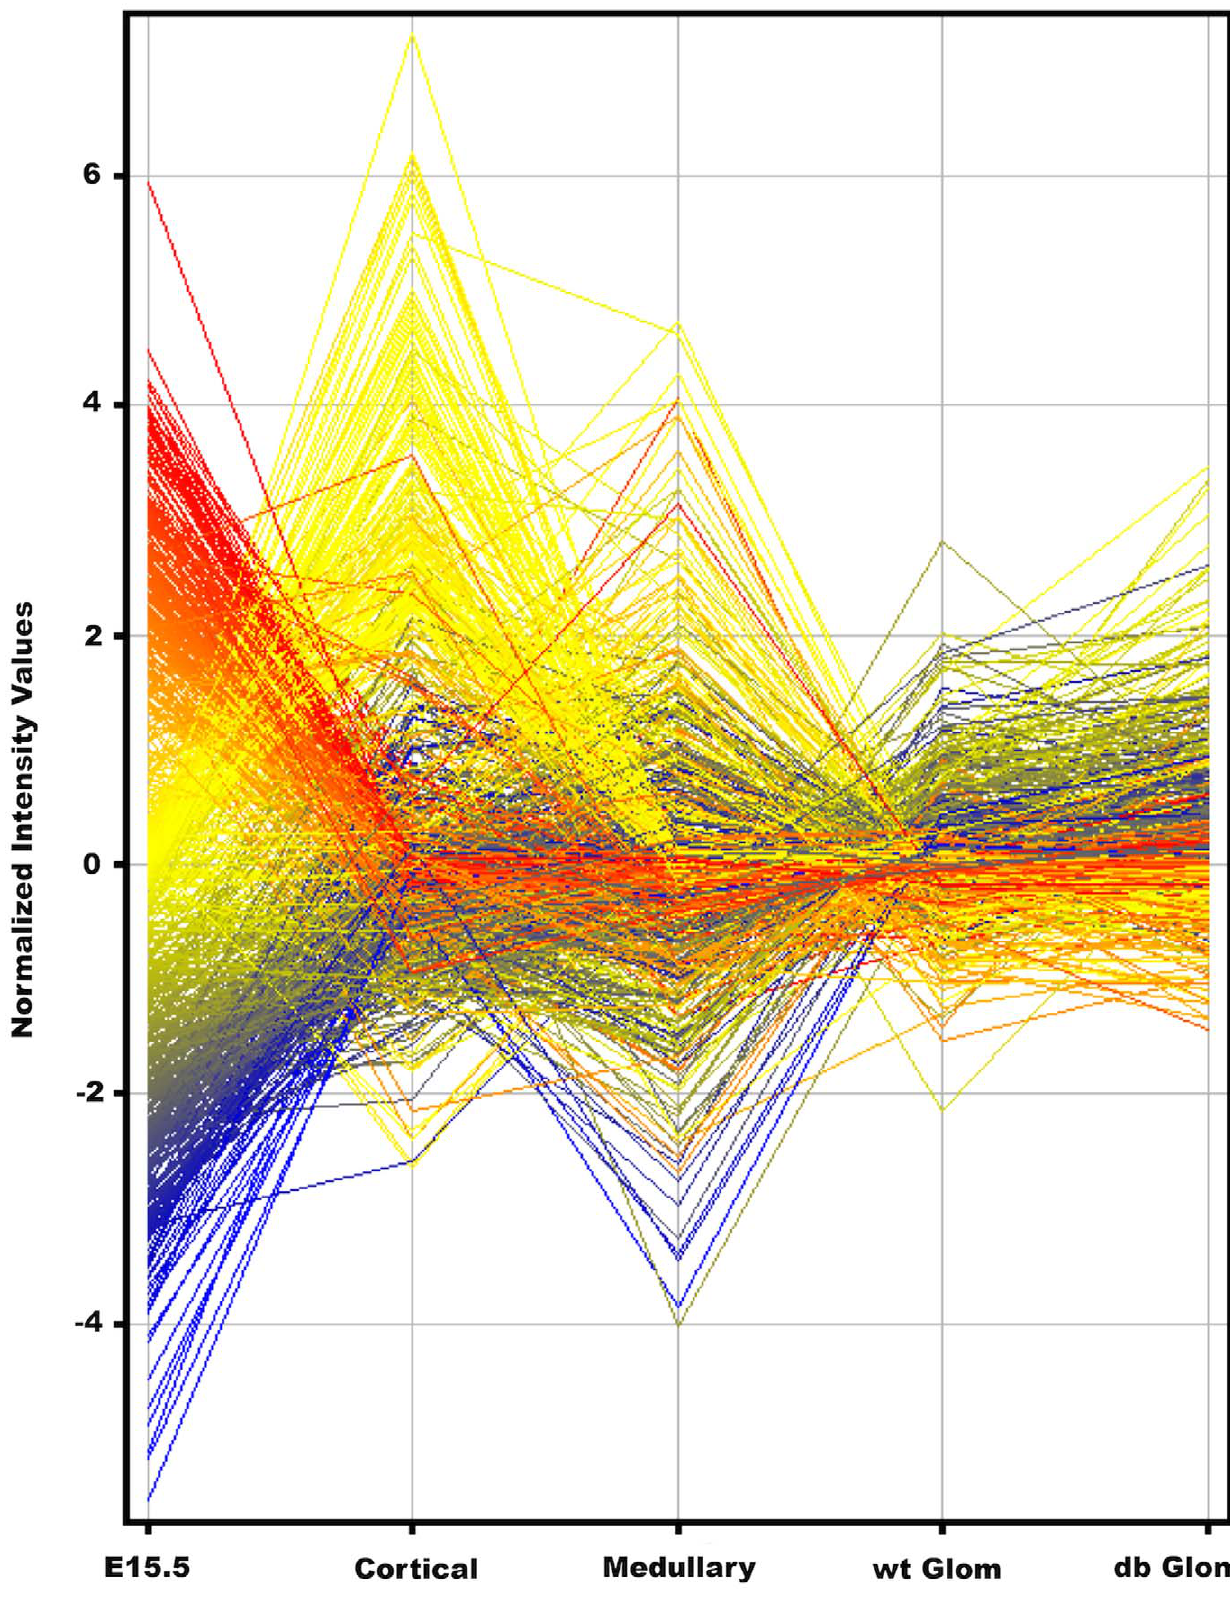
Figure 1. Profile plot of gene expression differences of renal endothelial cells isolated from different developmental times, compartments, and disease states. 786 probesets, each represented by a single line, color coded according to expression in embryonic cells, with red indicating high and blue representing low levels of expression. E15.5 , total E15.5 kidney endothelial cell population, Cortical , endothelial